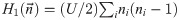
Comparison of AIC (Akaike Information Criterion) for 3 polynomial models with K = 6 females in N = 6 pots.(a) Hubbard: H1(n→)=(U/2)∑ini(ni-1). (b) linear H2(n→)=(V/2)∑iniI[ni-2]. (c) 3-parameters: H3(n→)=∑iWi(ni), with Wi(0) = 0, Wi(1) = ω1, Wi(2) = ω2, Wi(ni ≥ 3) = ω3. The maximum likelihood L is obtained, respectively, for U = 0.82, V = 0.52 and ω = (0.78, 2.41, 4.74). Here AIC = −2 log L + 2p + 2p(p + 1)/(M − p − 1), BIC = −2 log L + 2p log M, where p = (1, 2, 3) is the number of parameters and M = 10 is the numbers of measurements.